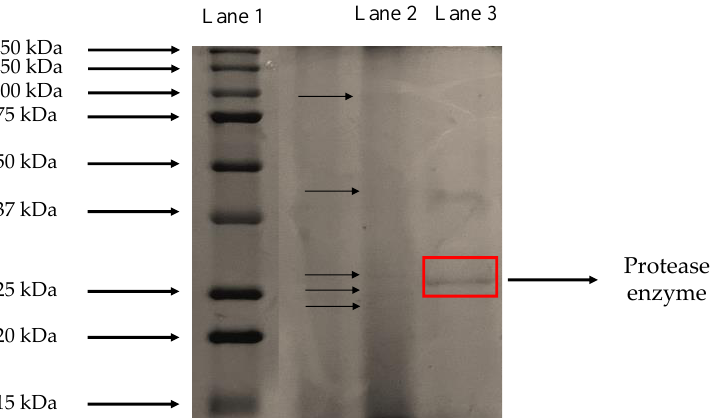
Figure 1. Electrophoresis analysis (SDS-PAGE) of crude and purified keratinolytic enzyme produced from feather meal bioconversion by Bacillus sp. P45. Lane 1: standard protein markers. Lane 2: crude extract enzyme. Lane 3: purified keratinolytic enzyme.